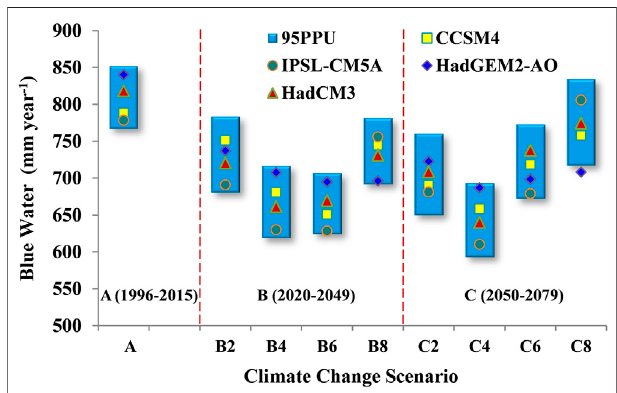
FIGURE 5 | Annual average blue water resources in different climate scenariossimulatedbybaselinescenarioA(1996 – 2015)andfourGCMs(HadCM3, IPSL-CM5A, HadGEM2-AO, and CCSM4) in the Xiangjiang River Basin. Note: Future scenarios B (2020 – 2049) and C (2050 – 2079) are subdivided into climate scenarios B2, B4, B6, B8 and scenarios C2, C4, C6, C8 according to the fourRCPs,RCP2.6,RCP4.5,RCP6,andRCP8.5,withintheabovefourGCMs,as illustrated in Section 2.4 ; the terms in Figures 6 , 7 are the same.